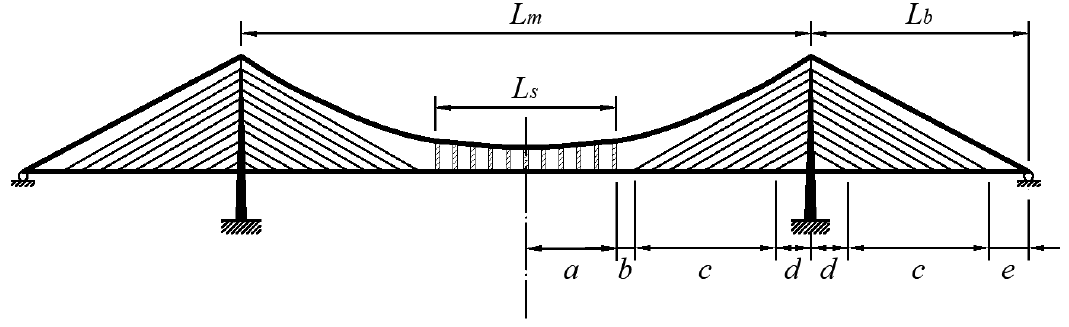
Figure 9. A rrangement of dimensional properties. Figure 9. Arrangement of dimensional properties.